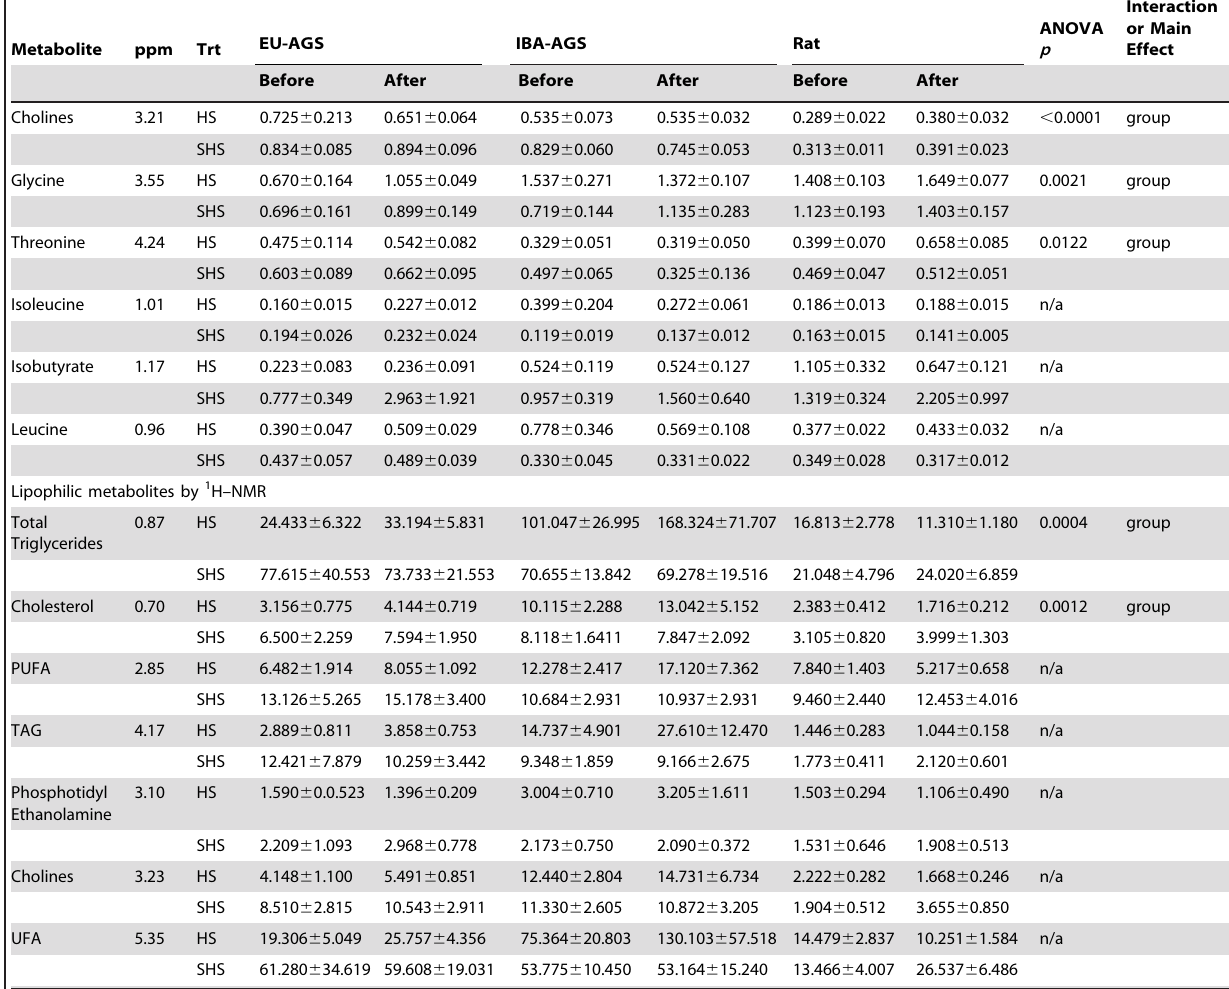
Group was defined as EU-AGS vs. IBA-AGS vs. rat. Treatment indicated sham vs. hemorrhagic shock. For all lipophilic parameters, difference in group was IBA . rat. ANOVA analysis included sham surgery animals as a treatment. n=5–7 for all groups. ANVOA value and significant differences ( p , 0.05, Tukey) are indicated. TAG, triacylglycerol; PUFA, Polyunsaturated fatty acids; UFA, unsaturated fatty acids.